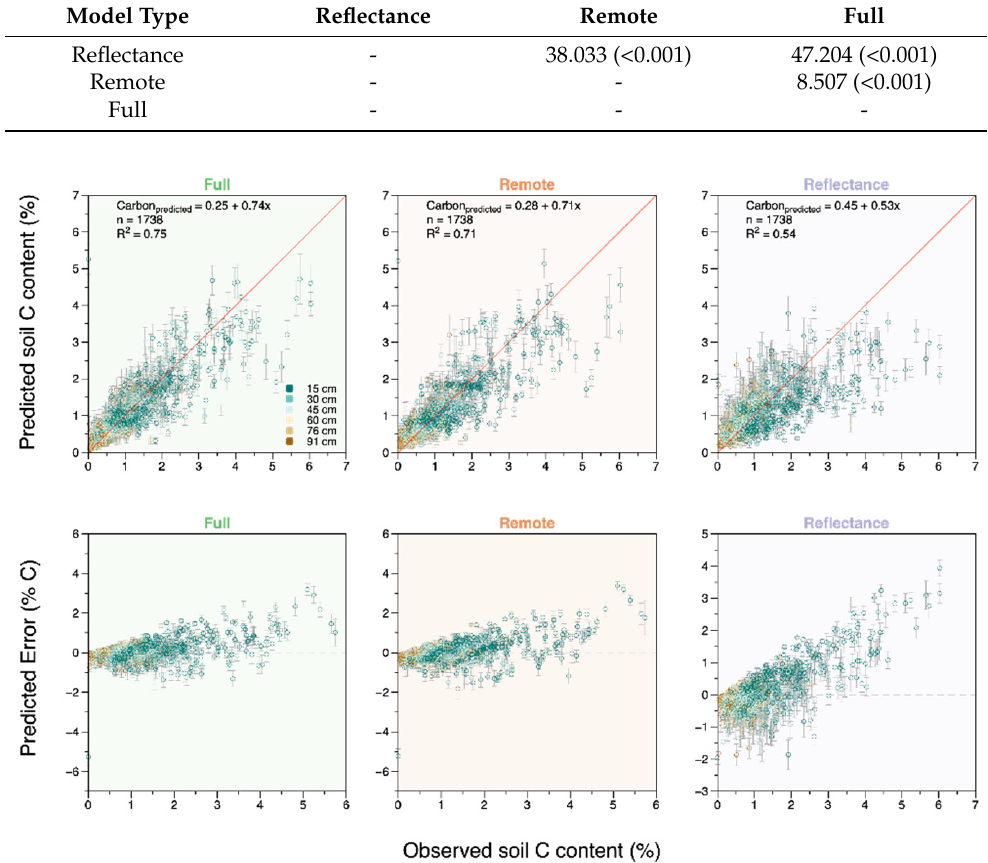
Figure 3. Predicted versus observed soil carbon content (%) and prediction error versus observed for soil carbon content ( n = 1738). Points represent the mean prediction or prediction error across 100 training/testing splits, and error bars around points represent the standard deviation across 100 training/testing splits. Circles with color represent the samples for various depths as shown in the legend. Red line represents 1:1 fit. Dotted grey line represents the line of best fit from soils collected from nineteen participating ranches encompassing approximately 17,347 ha in the Southern Great Plains ecoregion of the United States.